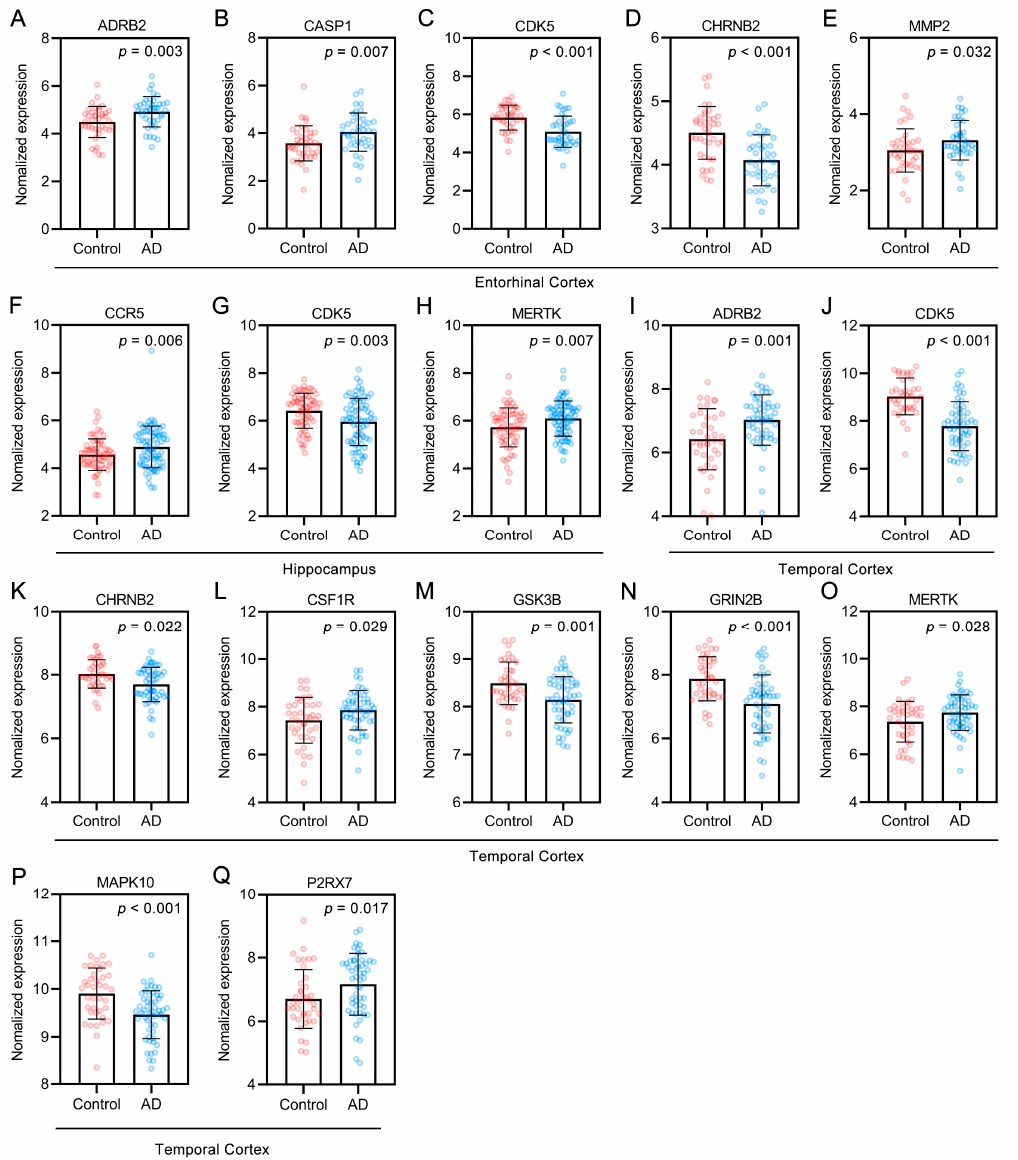
Figure 9. ( A – Q ) Targets of UR alkaloids against AD in the control and AD groups of the GEO dataset. Entorhinal cortex, n = 39 in each group. Hippocampus, n = 66 in the healthy control group, n = 74 in the AD group. Temporal cortex, n = 39 in the healthy control group, n = 52 in the AD group. Values are presented as the mean ± SD.